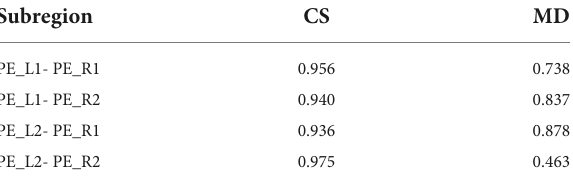
TABLE 2 Evaluation of similarity between fingerprints of PE